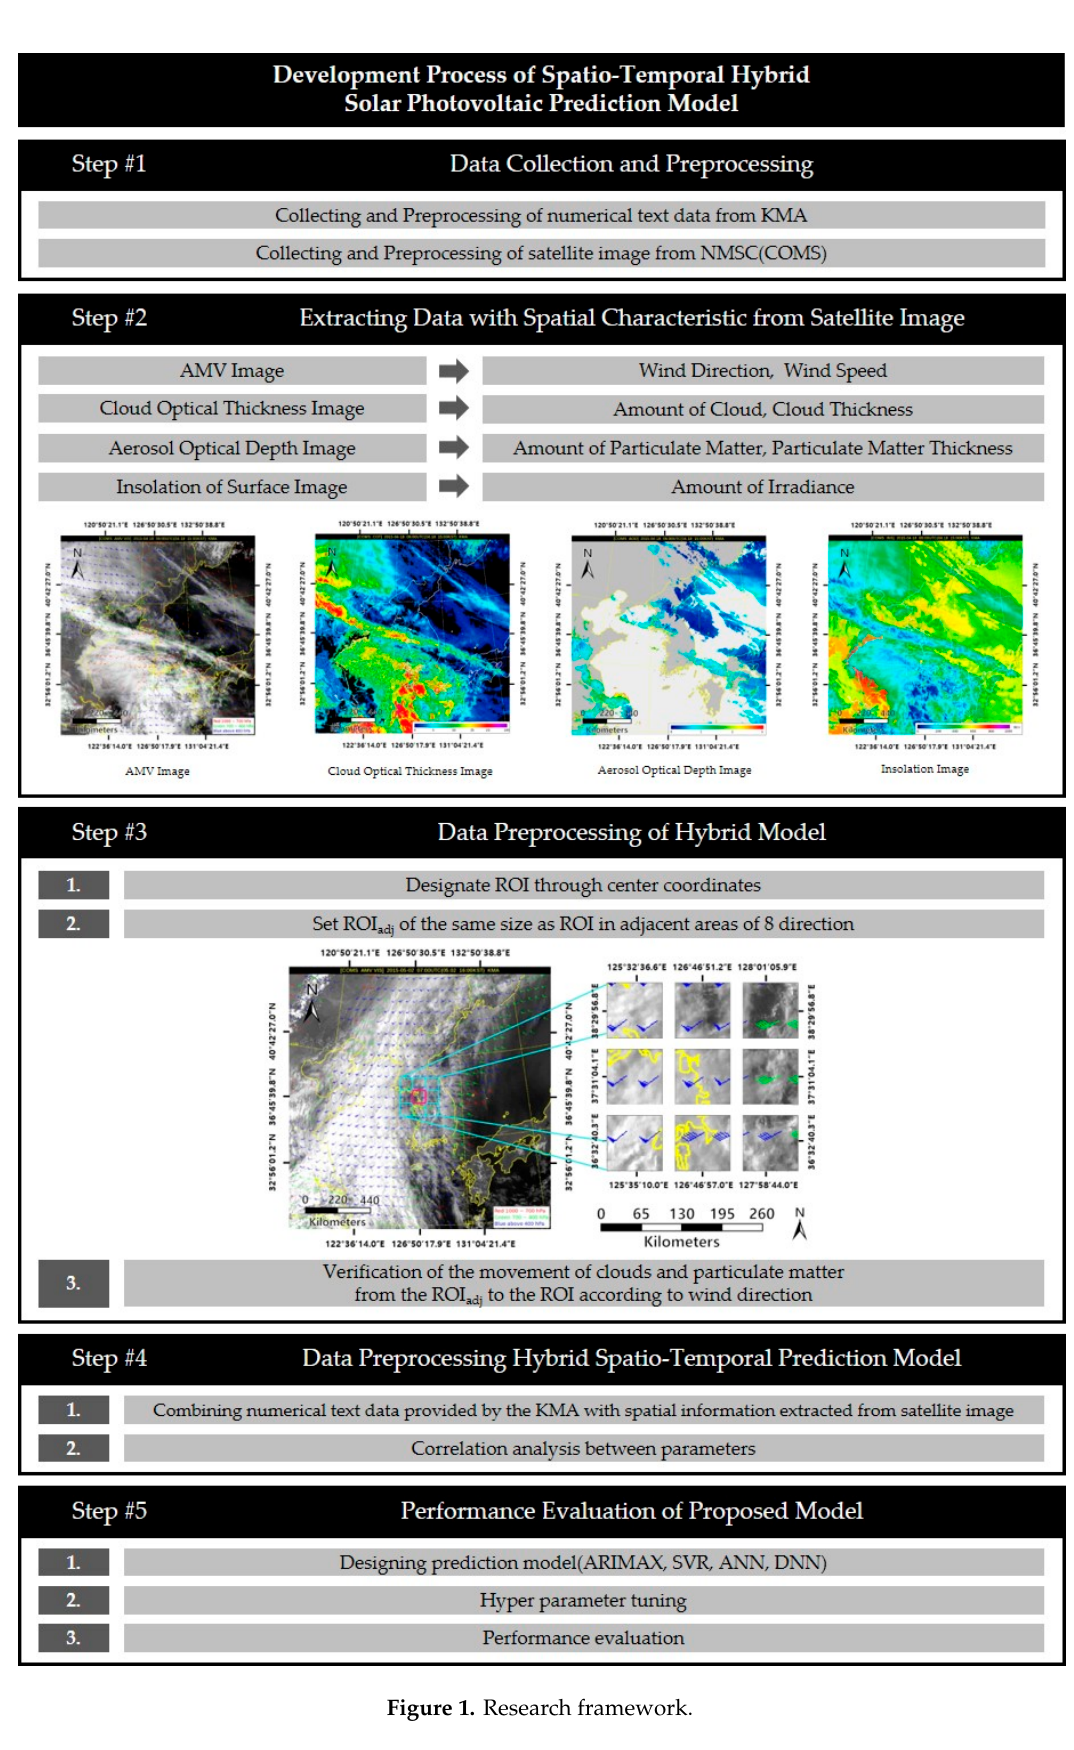
Figure 1. Research framework.